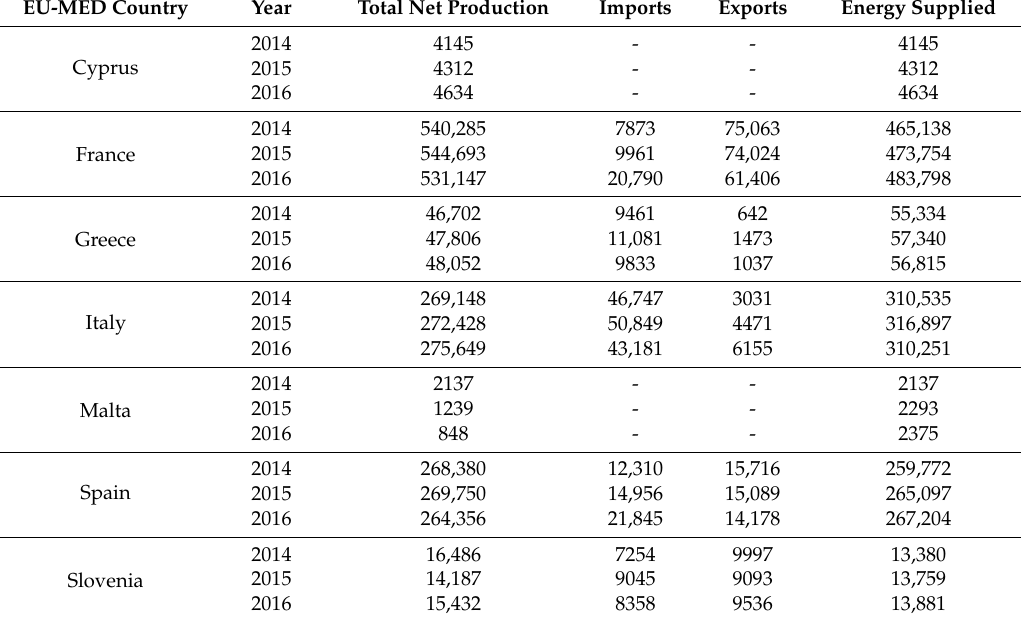
Table 1. Electricity statistics for EU-MED countries (in GWh). Source: Eurostat (online data code: nrg_105a,